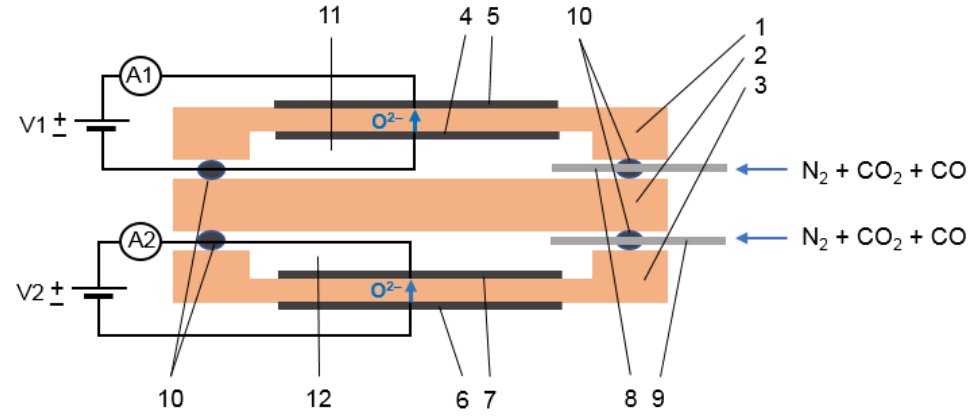
Figure 2. Schematic view of the sensor: 1, 2, 3 – YSZ ceramic plates; 4 – 7 – Pt electrodes; 8, 9 – ceramic capillaries; 10 – sealing glass; 11, 12 – inner chambers of the cells 1 and 2; V1 and V2 – DC voltages applied to the cells 1 and 2; A1 and A2 – ammeters.